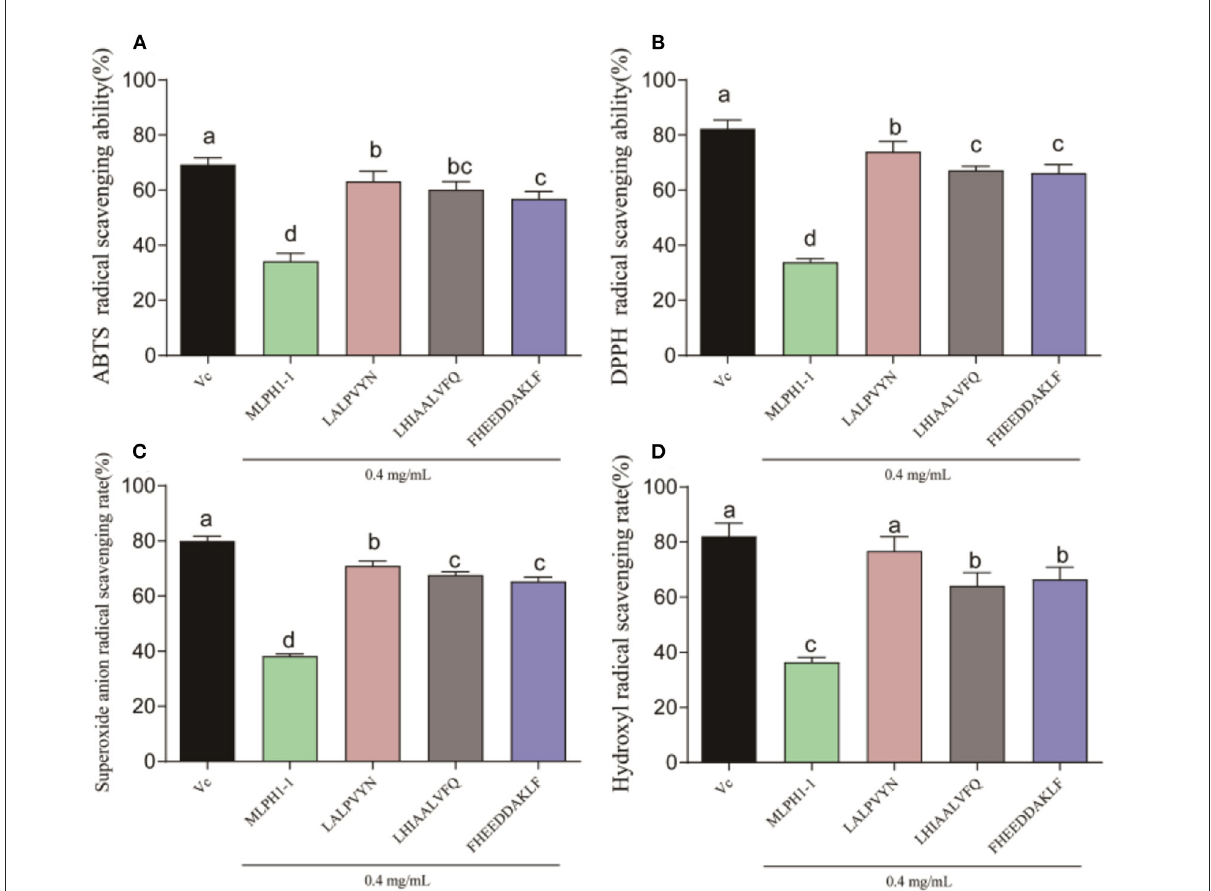
FIGURE3 Determination of the antioxidant capacity of each peptide. (A) ABTS radical scavenging ability; (B) DPPH radical scavenging ability; (C) superoxide anion radical scavenging ability; (D) hydroxyl radical scavenging ability. Data are expressed as mean ± SD from three independent experiments ( n = 3), results marked with the same letters were not significantly different ( P > 0.05).